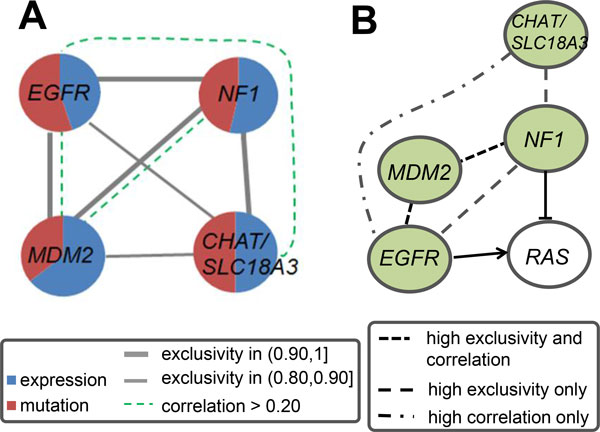
The fourth module identified by iMCMC in the GBM data and locations of the detected genes in known pathways. (A) Mutual exclusivity between any pair of genes is greater than 0.80 in this module. Thick gray line denotes a value more than 0.90 and thin line represents a value between 0.80 and 0.90. (B) The detected genes EGFR and NF1 are in the RTK signaling pathway, where the interactions are as reported in [2]. The dense dashed line represents pair of genes with exclusivity more than 0.90 and correlation larger than 0.20. The loosely dashed line represents exclusivity more than 0.90 only, and the dot-and-dash curve represents correlation larger than 0.20 only.